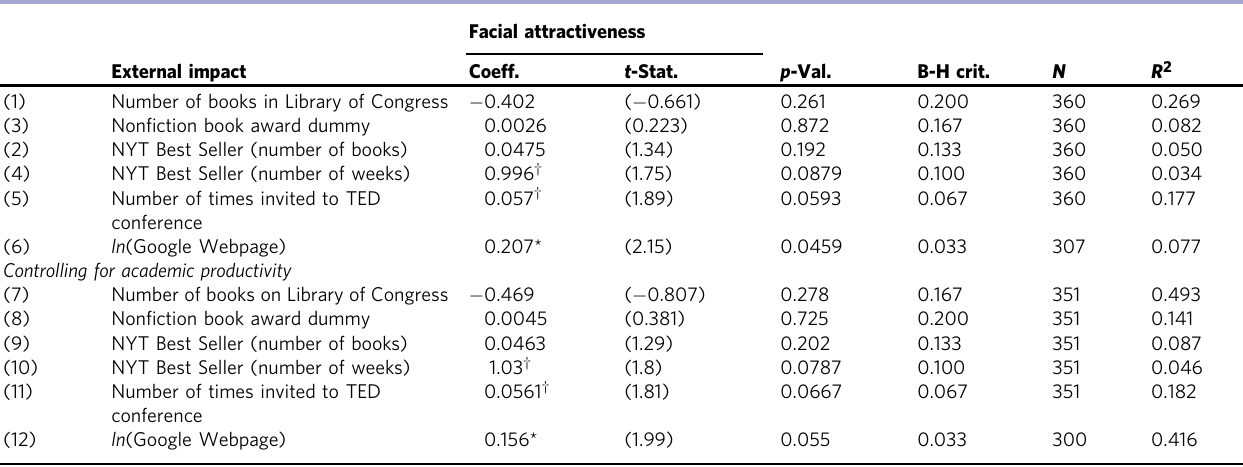
Table 3 Facial attractiveness and external engagement: Impact of academic speakers. Facial